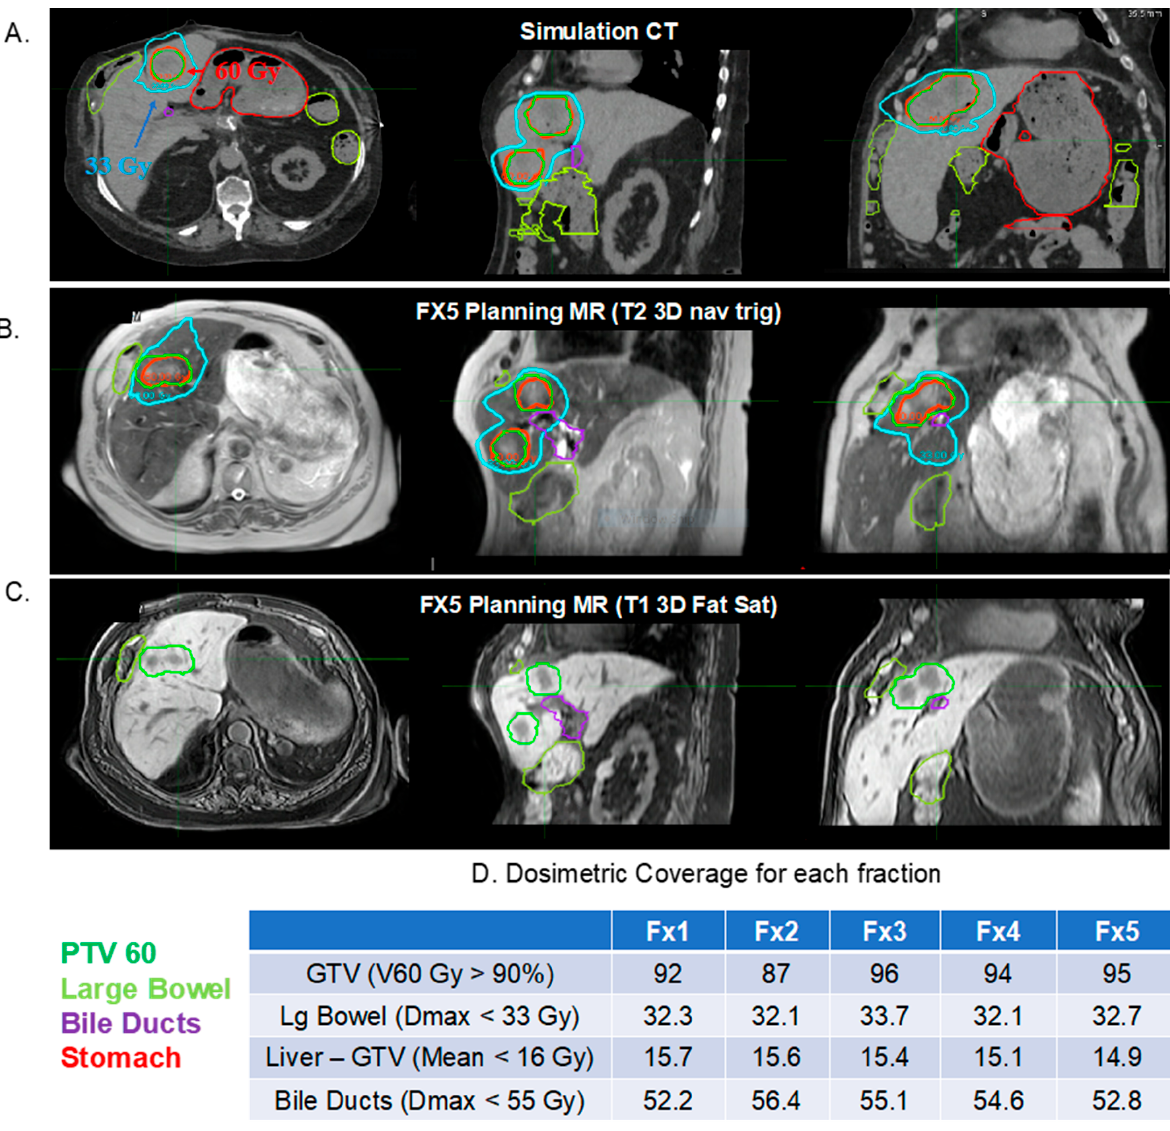
Figure 1. MR-guided adaptive radiation therapy. Seventy-two-year-old female with three liver metastases (2 cm lesion in segment 8 and segments 3/4B measuring 1.6 cm) treated using MRg-ART on Elekta Unity MR-linac to a prescription of 60 Gy (12 Gy in 5 fractions). ( A ) The tumor metastasis was not visible on non-contrast planning CT as the patient was not a candidate for iodinated IV contrast due to poor renal function. Patient was simulated supine in a custom immobilization device and with an abdominal compression belt to minimize respiratory liver motion to <5 mm. ( B ) Online adaptive plan for a fraction on a T2 3D navigator triggered MRI. ( C ) T1w 3D fat saturated MRI was used in combination with T2 3D navigator triggered sequence to delineate GTV and OARs during online planning. Daily adaptive planning was performed to account for coverage of multiple lesions (due to varying deformations in the liver) as well as to protect the organs at risk. Bile ducts were used as the monitoring structure on the three orthogonal plane balanced fast field echo cine MRI during radiation delivery. ( D ) Daily dosimetric coverage for GTV and various relevant OARs. Each fraction dose is displayed in terms total prescription dose.